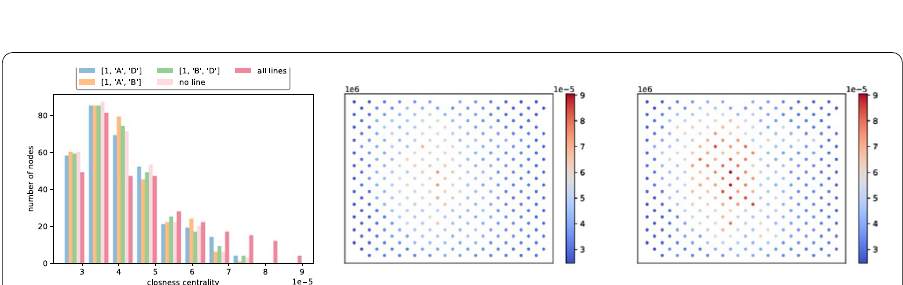
Fig. 12 Histogram of DANCC and its spatial distribution in the “Festival of Lights”